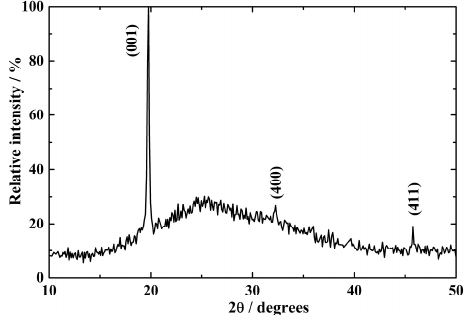
Figure 1. XRD pattern of the electrodeposited V 2 O 5 coatings on SnO 2 ‐ precoated glass substrates using current density of 1.3 mA cm − 2 and electrolyte concentration of 0.5 M for a growth period of 15 min at room temperature.